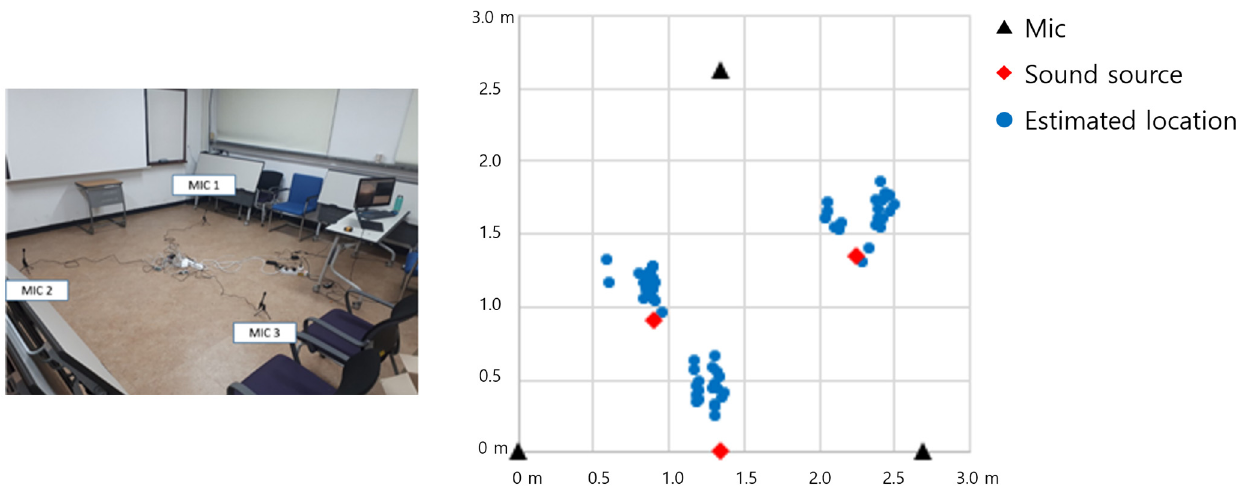
Figure 5. 2D localization results with a triangular array.